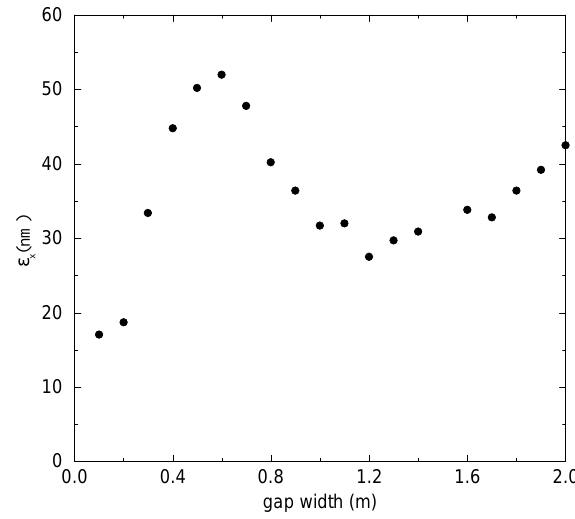
FIG. 13. Gap width dependence of the emittance